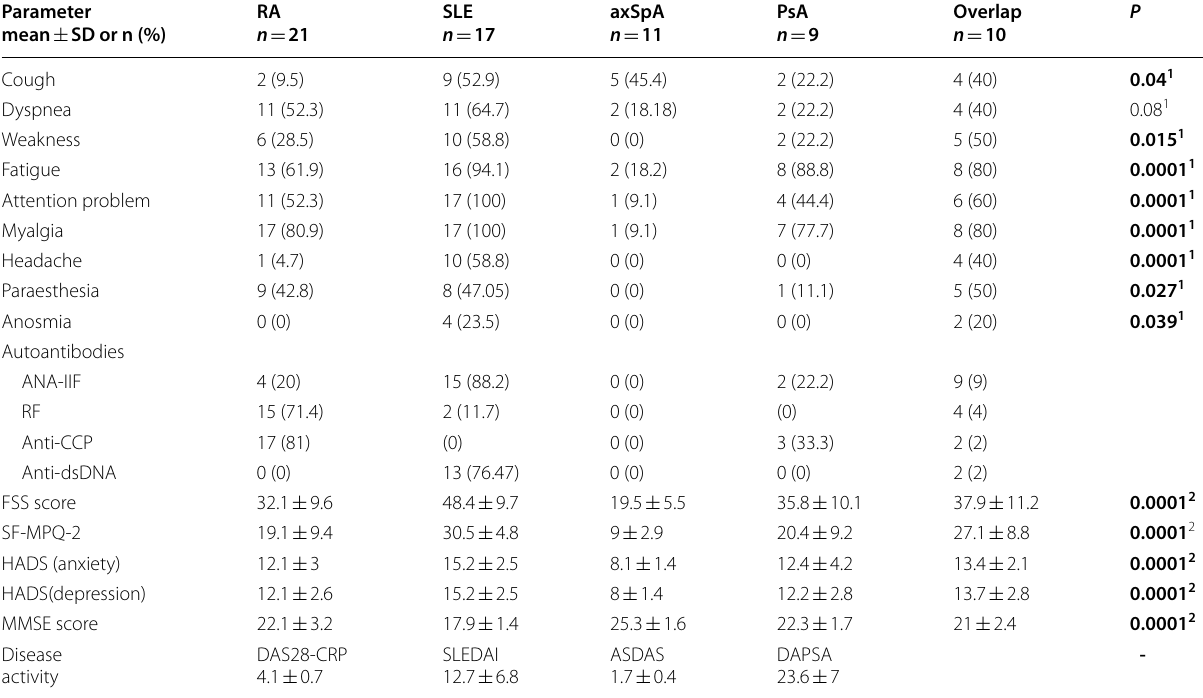
Table 2 Comparison of post-COVID-19 syndrome symptoms in rheumatic diseases patients